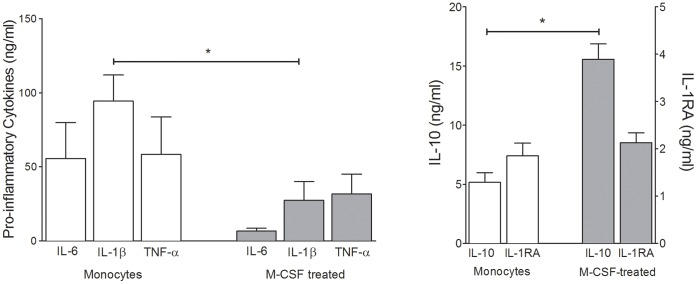
Purified monocytes and M-CSF treated (10 ng/ml) purified monocytes from the same donor were incubated with CRP (200 µg/ml) for 24 h and supernatants were analyzed for pro-inflammatory and anti-inflammatory cytokines.Control values were several thousand-fold less than treated values. Monocytes secreted pro-inflammatory cytokines in response to CRP, which decreased after M-CSF differentiation. The differentiated monocytes secreted anti-inflammatory cytokines, IL-1RA and IL-10. *, P<0.05 vs. purified monocytes; nonparametric Mann Whitney test was used to analyze differences between groups. Mean ±SEM of triplicate wells from 3 independent experiments.